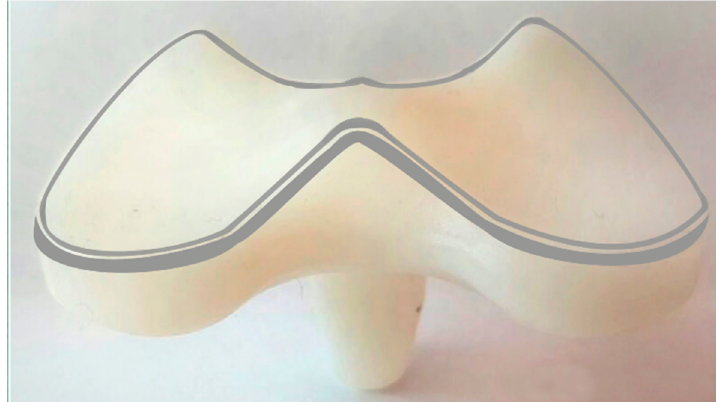
Figure 3. Unworn portions (grey areas) taken into account for the alignment.